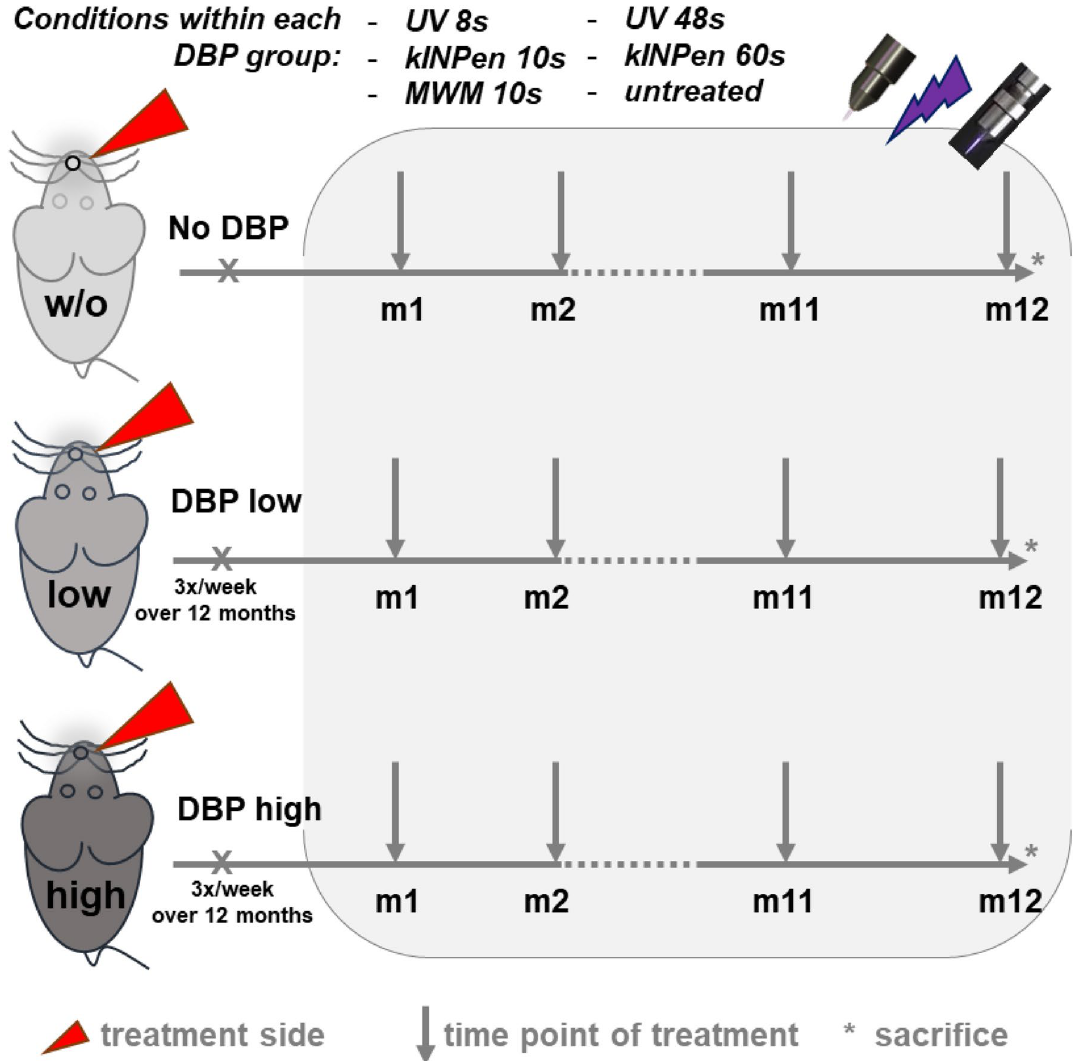
Figure 1. Flowchart of the study. Mice received either none or administrations of low (3 nmol) or high (24 nmol) concentrations of the co-carcinogenic substance dibenzo(a)pyrene (DBP) into the oral cavity three times per week over the entire study period of 12 months. The DBP administration was paralleled by a monthly treatment of the right cheek with either UV (ultraviolet) 8 s, UV 48 s, kINPen plasma 10 s, kINPen plasma 60 s, or MWM plasma 10 s across the period of 12 months. After sacrifice, sampling of tissue for downstream analyses was performed. Each group contained 19–26 finding was detected within the DBP low dose regimen, showing a slightly higher number of overall changes, while most changes occurred in the DBP high dose regimen, with a notable increase of HIF1A and IL1RN with most treatments. Across all regimens and treatments, fairly consistent changes occurred for IL33 , H2-K1 , and SMAD3 . Changes in transcript expression levels of the chemokines CCL19 , CCL8 , and CXCL12 were also fre- quent but instead found in the non-kINPen conditions. The more pronounced signature of changes in the high dose DBP regimens was also reflected in all groups’ principal component analysis (PCA) (Fig. 7). All treatments within this regimen differed highly in PC1 and/or PC2, with the UV 48 s treatment differing the most. By con- trast, except for UV 8 s (low dose DBP), all other samples clustered together. This result suggests the overall effect of the plasma or UV treatments on the gene expression profiles in the low dose and none DBP-regimens to be minor compared to the profound changes observed with high dose DBP per se. Interestingly, the tumor promoter transcript of osteopontin ( SPP1 ) was highly upregulated in the control and UV treatments with high dose DBP, while plasma treatment strongly attenuated its expression. Moreover, the 60 s kINPen plasma treatment, which reduced absolute lesion and tumor sizes significantly, was the only treat- ment not showing a reduction in ACVR1B , ACVR2A , CSF1 , EGF , EGFR , IL15 , and IL6RA when compared to all other treatments in the high dose DBP group. In summary, our data suggest that repeated plasma exposure be void of carcinogenic effects when applied alone or in combination with the co-carcinogen DBP. Also, the overall changes in gene expression in the plasma treatment groups were minor in the DBP none and low dose regimens,